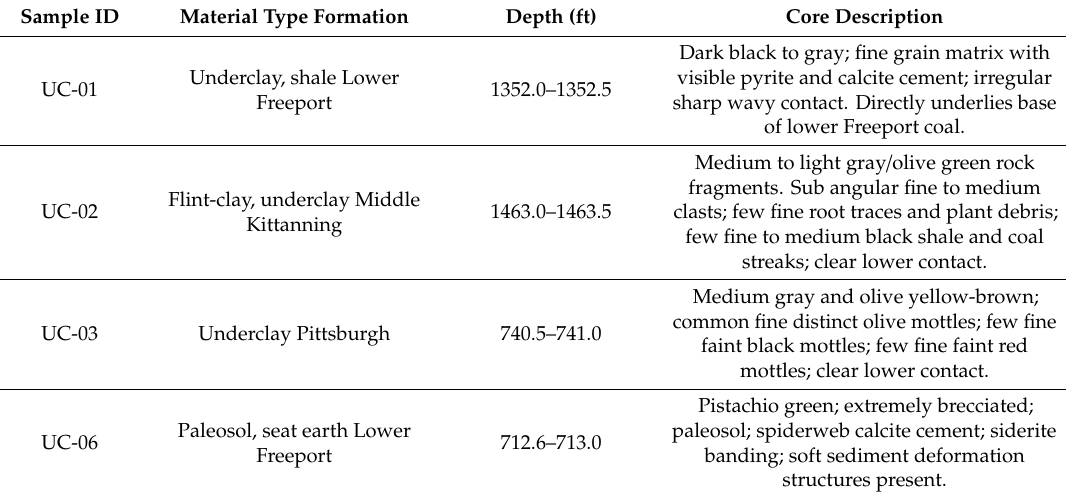
Table 1. Sample information and core descriptions for underclay